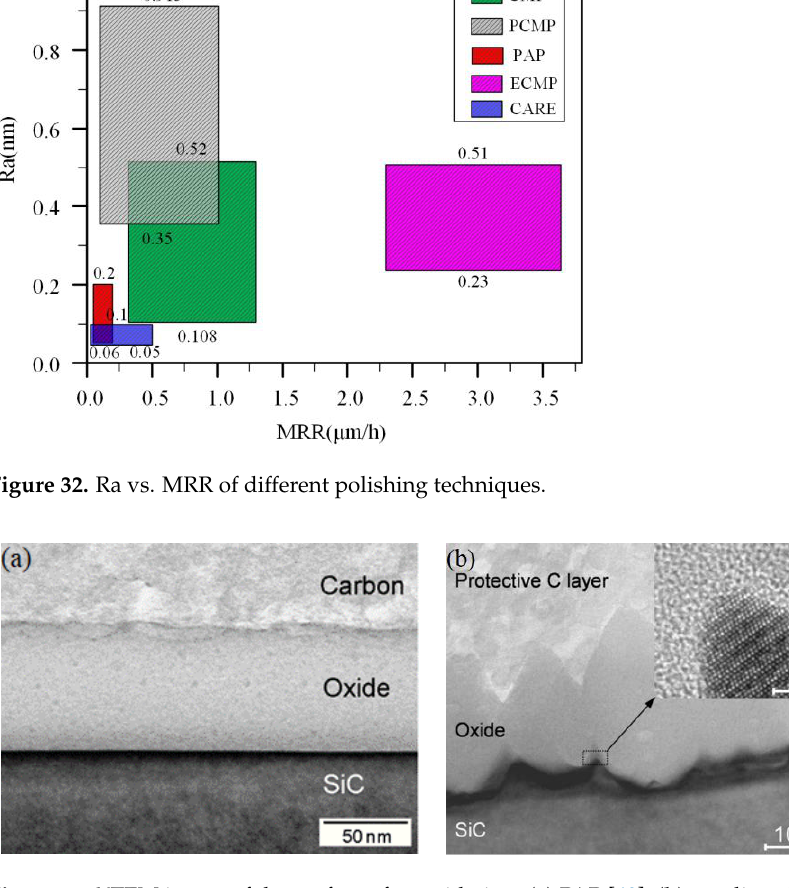
Figure 33. XTEM image of the surface after oxidation: ( a ) PAP [40] , ( b ) anodic oxidation [15] .